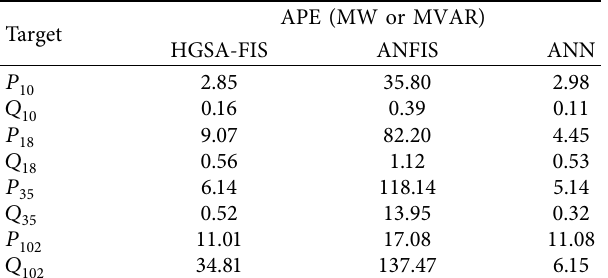
Table 3: Maximum APE of HGSA-FIS, ANFIS, and ANN models. Table 4: Performance of HGSA-FIS, ANFIS, and